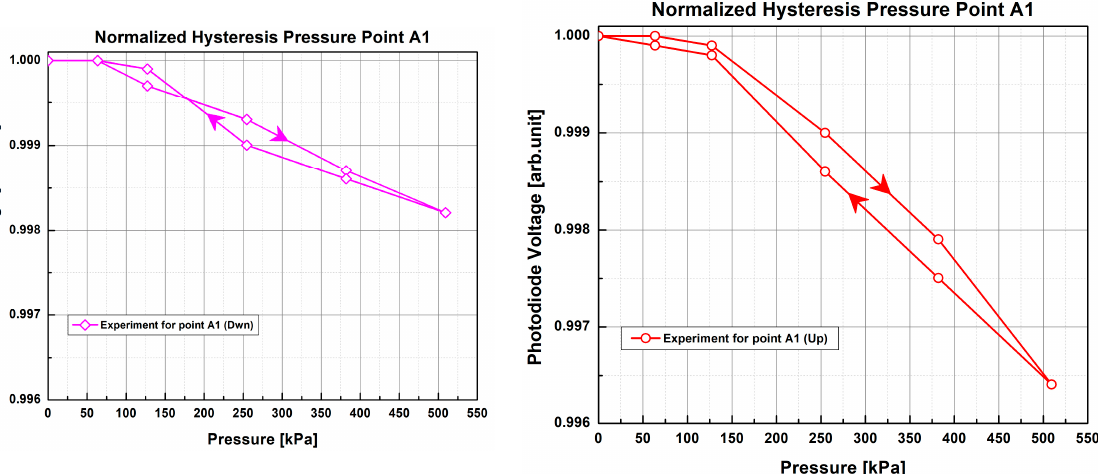
Figure 11. Hysteresis curves of the 1 POF × 1 POF sample with the low-cost electronics setup at pressure point A1. The experimental data points correspond to the average of two test repetitions. The arrows indicate the direction of applied pressure (i.e. downward and then upward).